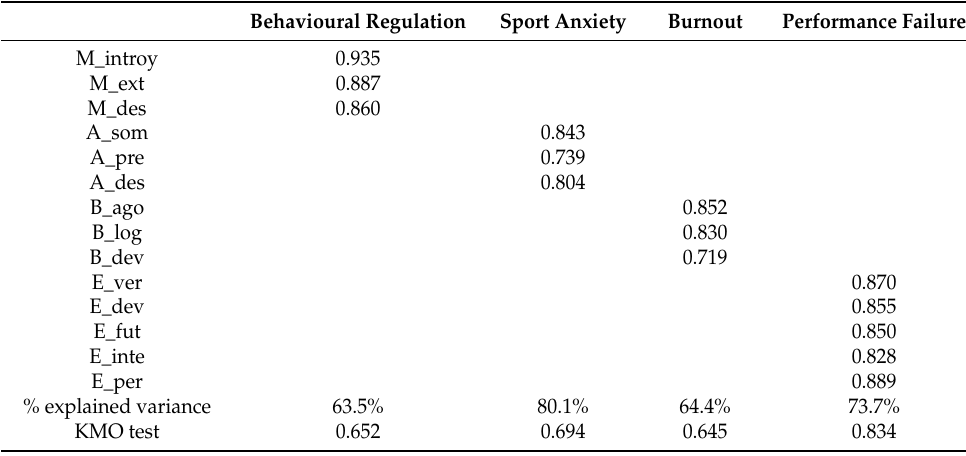
Table 2. Exploratory factor analysis of the